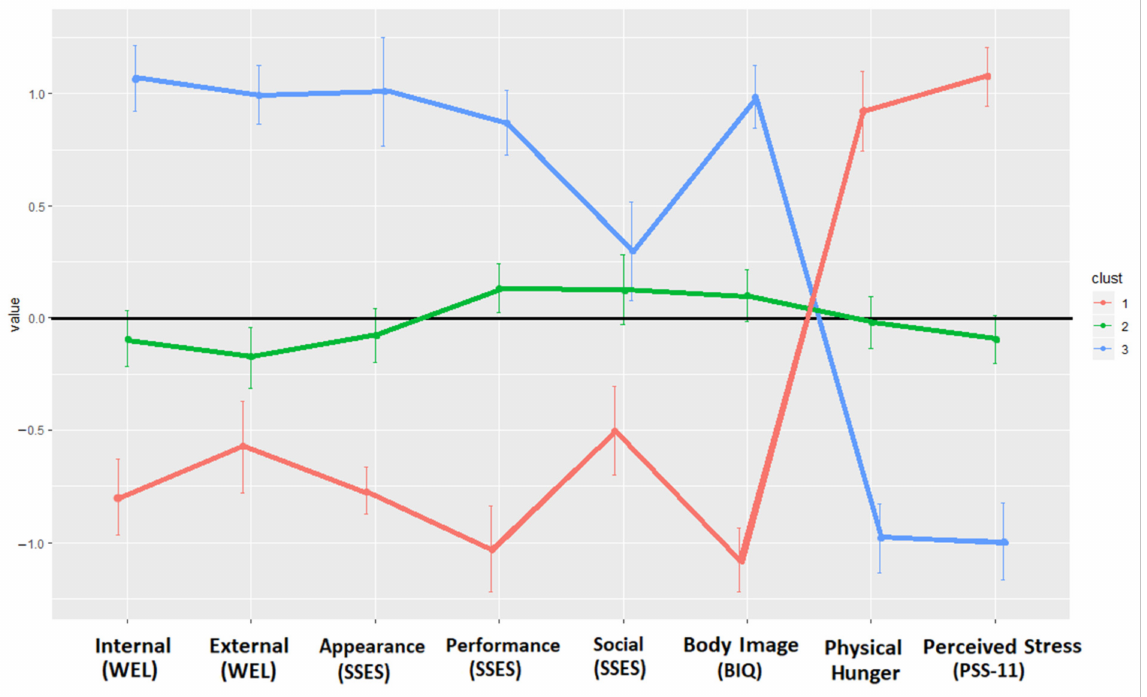
Figure 2. Graphical presentation of the clusters identified in the male subsamples. Note. Internal (WEL): Resistance to internal stimuli; External (WEL): Resistance to external stimuli; Appearance (SSES): Appearance state self-esteem; Performance (SSES): Performance state self-esteem; Social (SSES): Social state self-esteem; Body Image (BIQ): Body Image Questionnaire; Perceived Stress (PSS-11): Perceived Stress